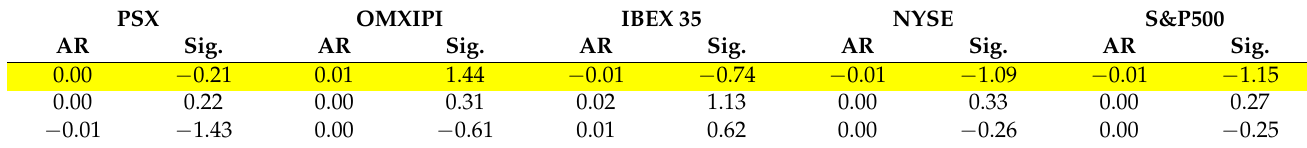
Table A26. Abnormal returns of the (0, +2) event window (Jurgen Mossack Resignation).